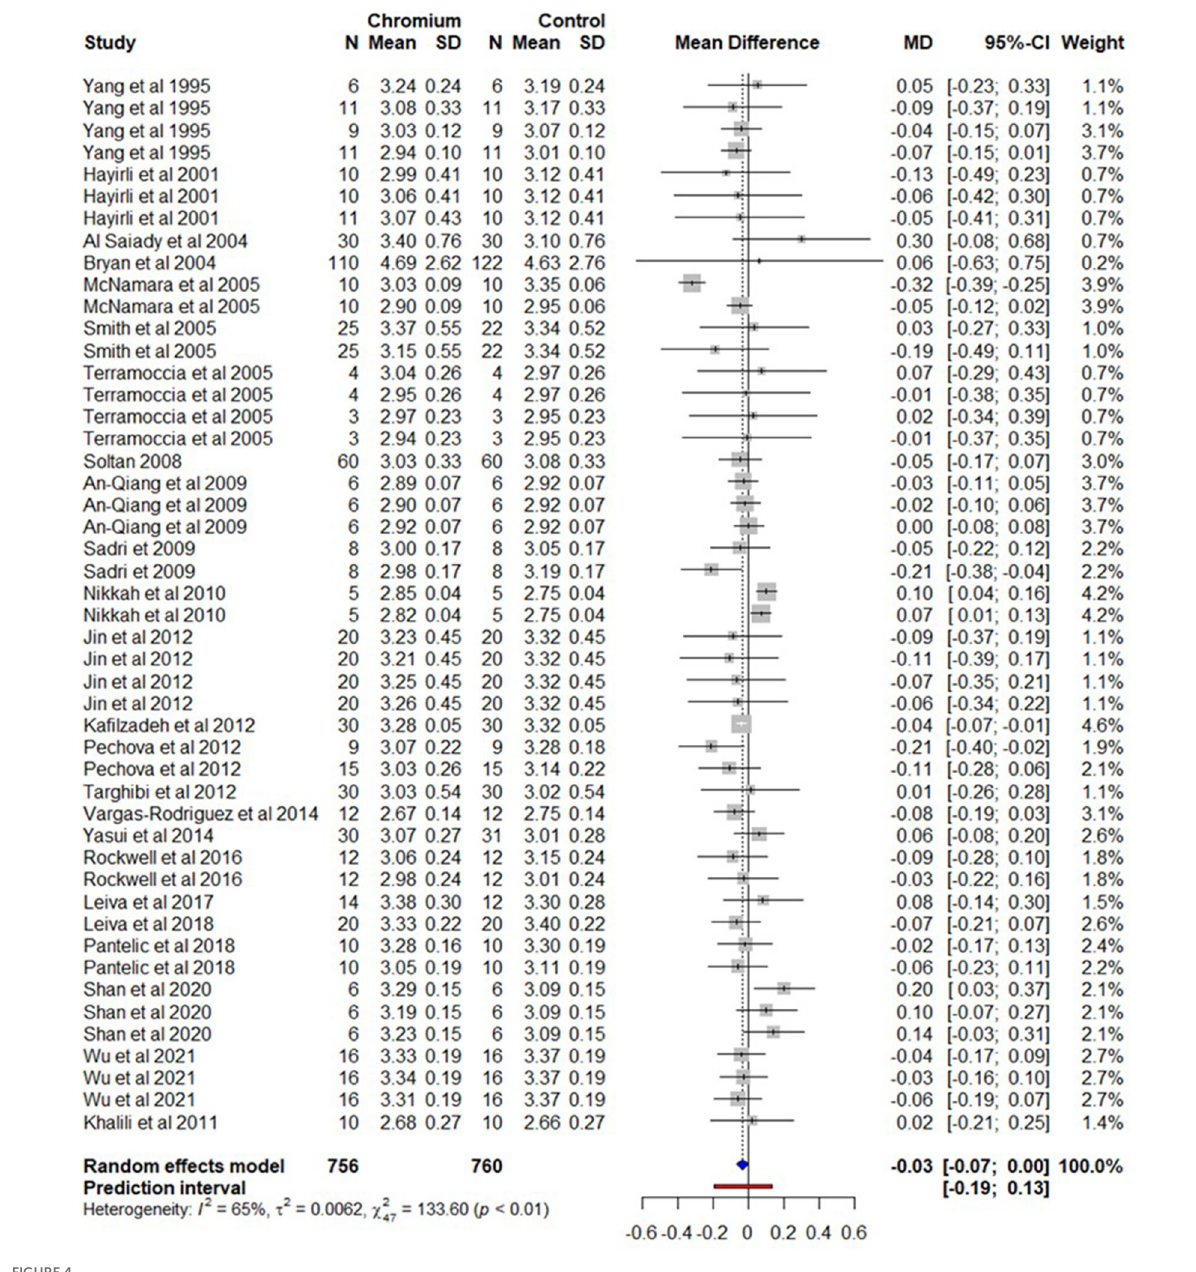
FIGURE4 The forest plot of the random-effect meta-analysis for milk protein content. The effect size was calculated as the mean difference (MD), and the solid vertical line represents the line of no effect or zero line. The dotted vertical line represents the average effect size for milk protein content in cows supplemented with chromium. The negative value under the MD heading indicates a decrease in milk protein content and vice versa. The black horizontal line represents the confidence interval for each study and the gray square represents weight or effect size of the corresponding study. The blue diamond represents the average effect size of the